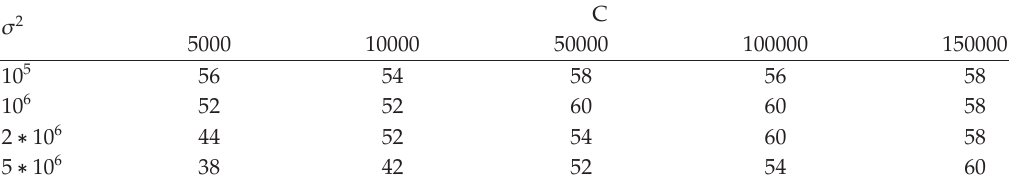
Table 2: Predicting results of